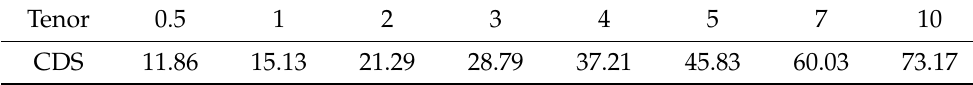
Table 2. Market Data of Tenor (year) and CDS spread (bps).